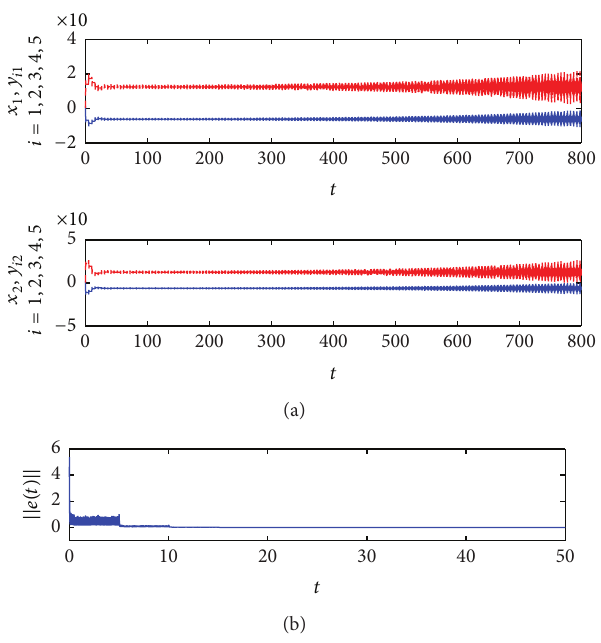
Figure 6: Evolution of (a) state trajectories of drive (the dash line) and response systems (the solid line) and (b) projective synchronization error under impulsive control.